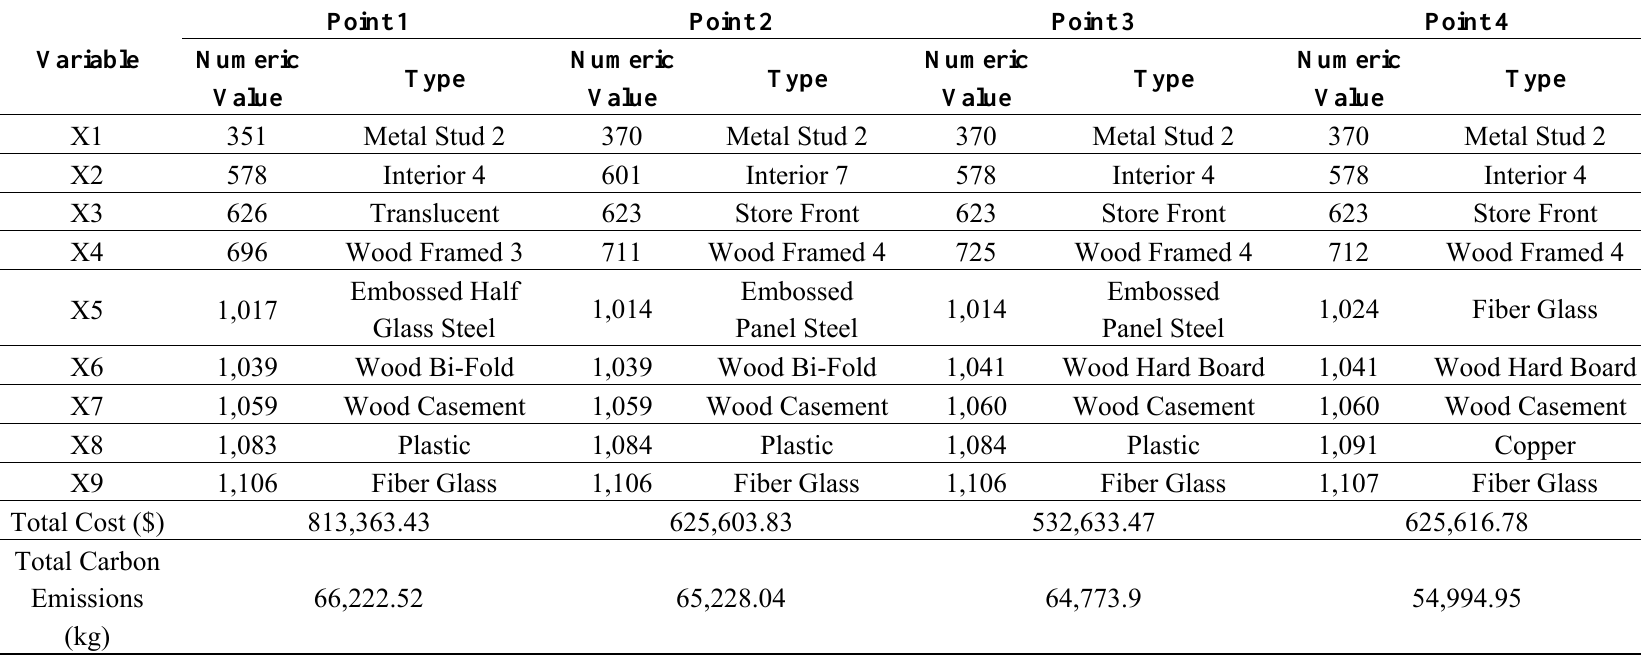
Table 8. Optimal Solutions based on Scenario